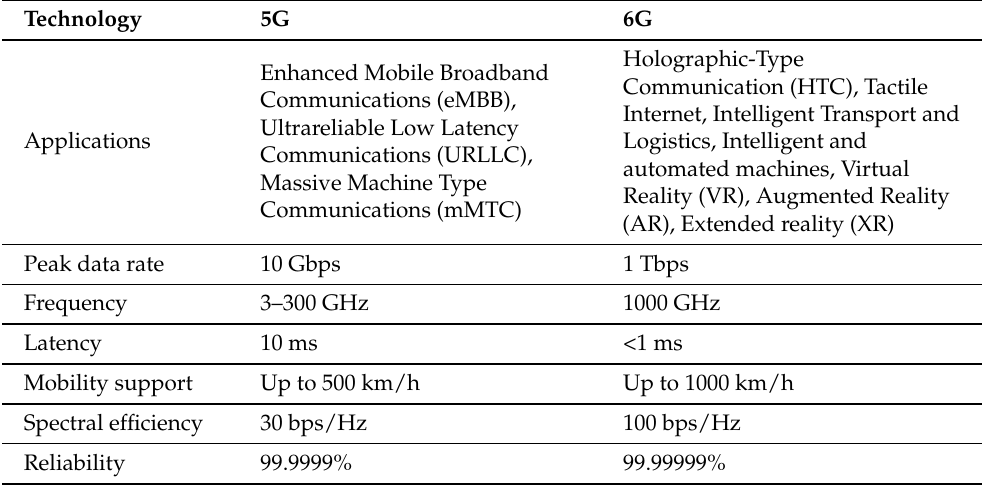
Table 1. Comparison of 5G and 6G